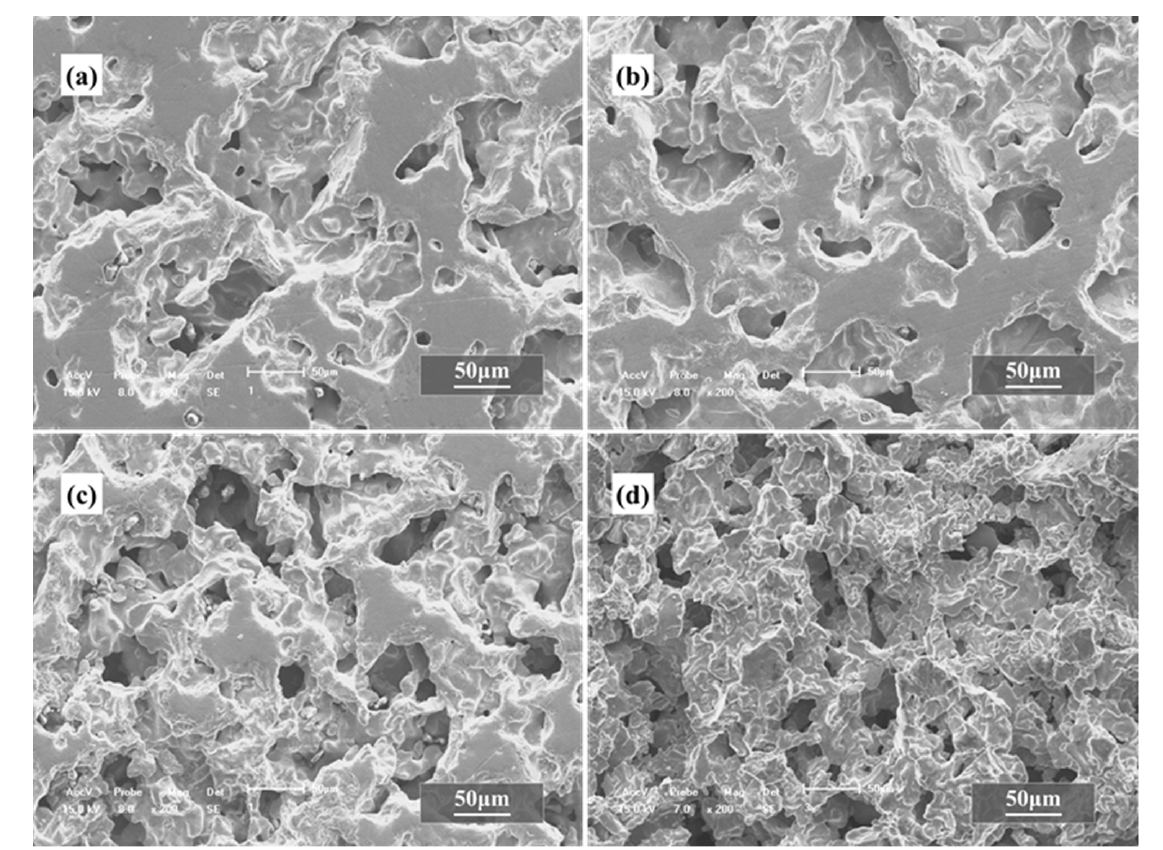
Figure 6. SEM images of porous titanium by mixed powders with different volume fraction of mag- nesium powders after sintering: ( a ) 50 vol.%, ( b ) 60 vol.%, ( c ) 70 vol.%, ( d ) 80 vol.%.